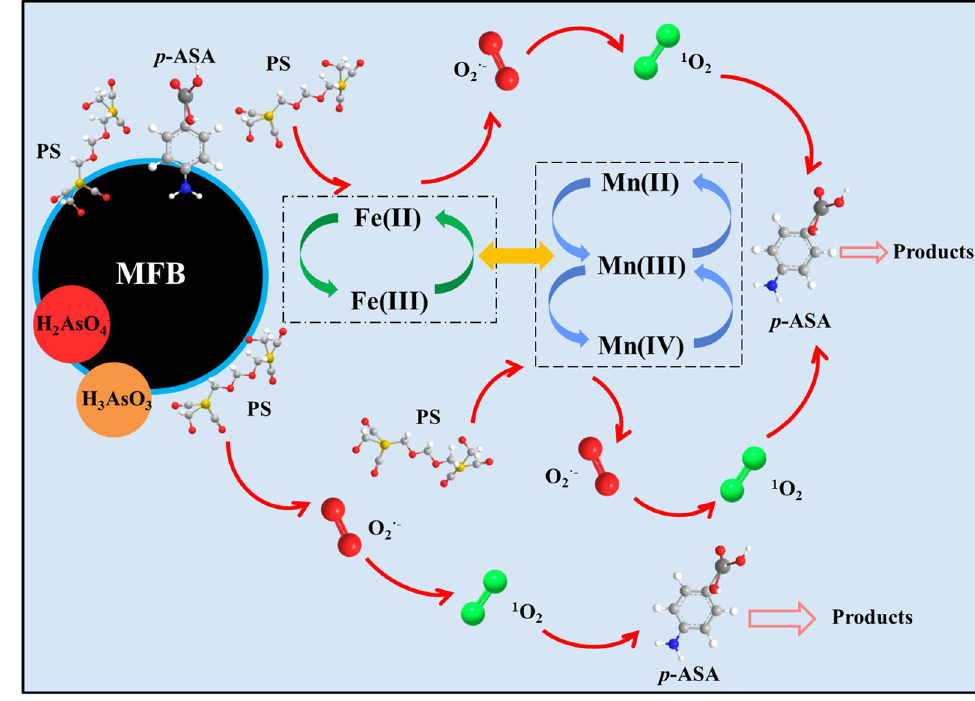
Fig. 6 The mechanisms of p -ASA degradation and simultaneous adsorption removal of arsenic in the MFB/PS